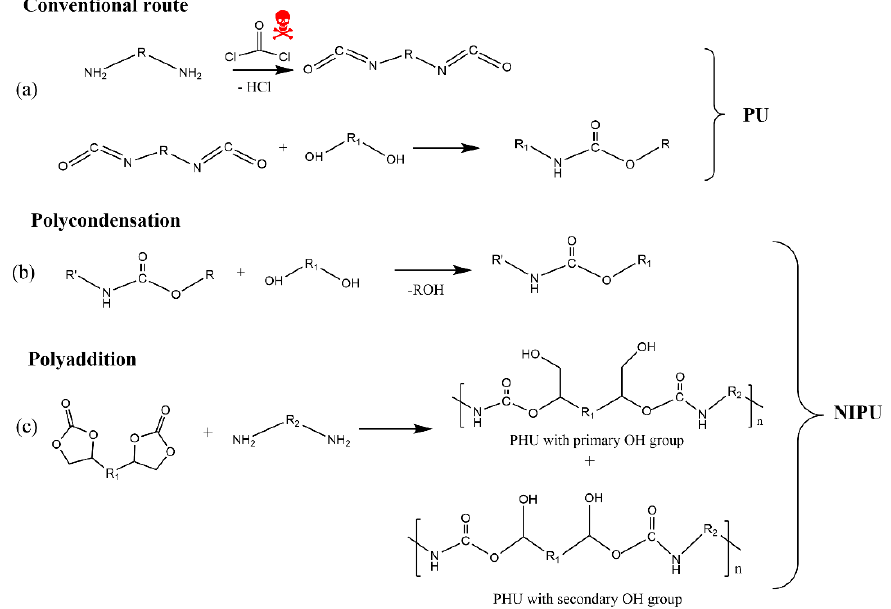
Figure 10. Chemical routes to produce PU by (a) conventional route, NIPU by (b) polycondensa- tion, and (c) polyaddition. and ( c )